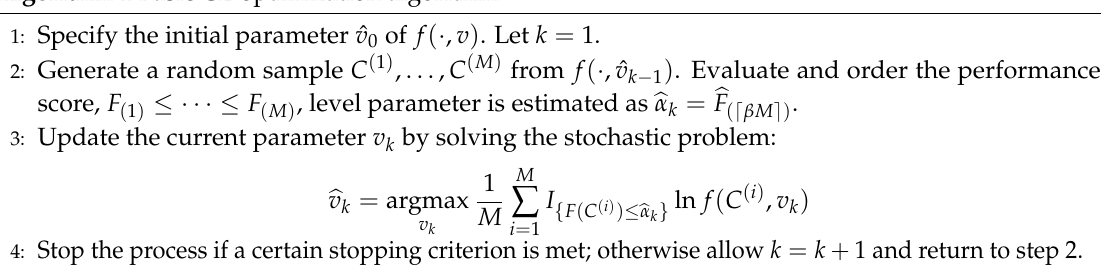
Algorithm 1 Basic CE optimization algorithm.